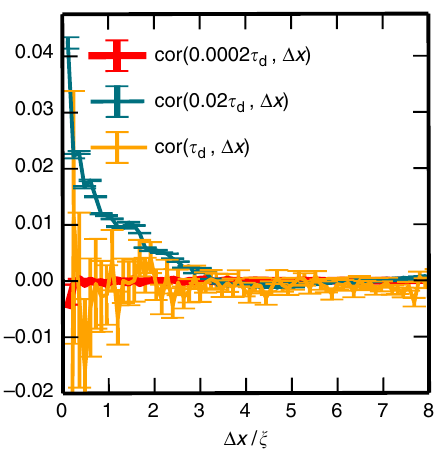
Fig. 3 Spatial correlations of transverse fl uctuation. The covariance cov( Δ t , Δ x ) of transverse fl uctuations r k ? ; of beads at position i on i neighbouring chains k and l during a time interval Δ t , as a function of (cid:5) (cid:5) (cid:5) (cid:5) , and normalised with respect to ð t þ Δ t Þ (cid:4) r l ð t þ Δ t Þ the distance Δ x ¼ r k i i cov( Δ t ,0): cor( Δ t , Δ x ) : = cov( Δ t , Δ x )/cov( Δ t ,0). Simulations were performed for an entangled solution with ξ / L = 0.086 and ‘ p = L ¼ 1, and at different times t . As expected, for very small times t ≲ τ e (red curve), there is no correlation. In contrast, for times in the intermediate regime, τ ≲ t ≲ τ = 0.02 τ e eq (here t d ), there are clear spatial correlations spanning a distance of about three times the mesh size ξ . These correlations vanish for times larger than the equilibration time, e.g., for times equal to the